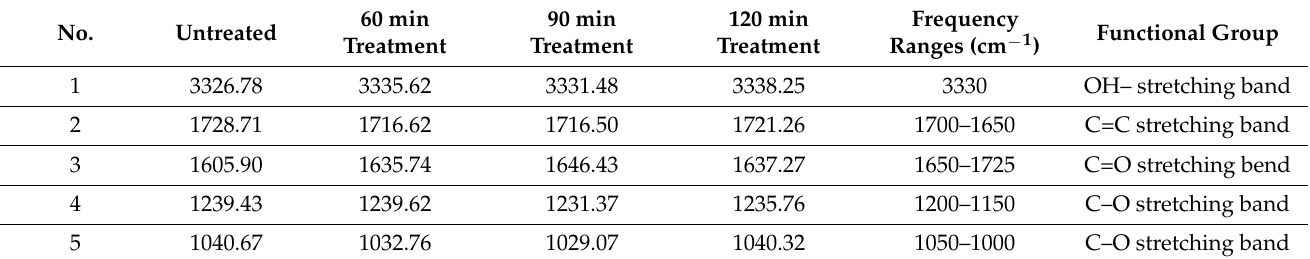
Table 3. FTIR analysis for MA-treated KBF at different treatment